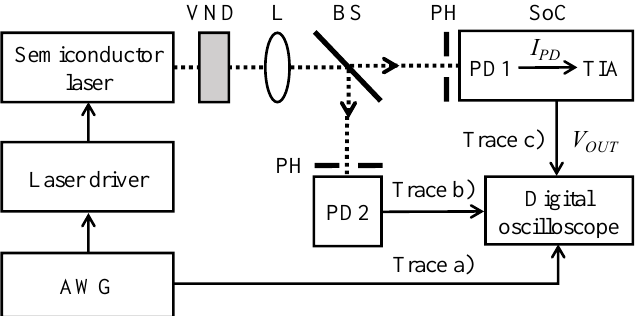
Figure 7. Experimental setup employed for the complete characterization of the fabricated optoelec- tronic sensing SoC; AWG is an arbitrary waveform generator, VND is a variable neutral density filter, L is a collimating and focusing lens system, BS is a 50/50 beam splitter, PH is a pinhole, PD1 the integrated Si photodiode on the fabricated SoC, and PD2 is the calibrated commercial Si photodiode.